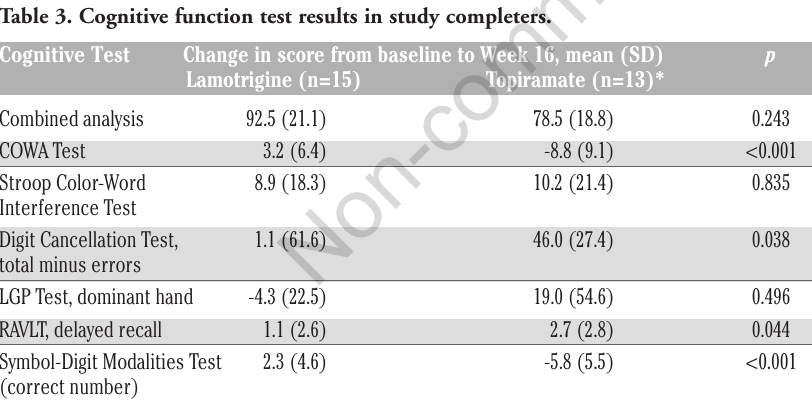
Table 3. Cognitive function test results in study